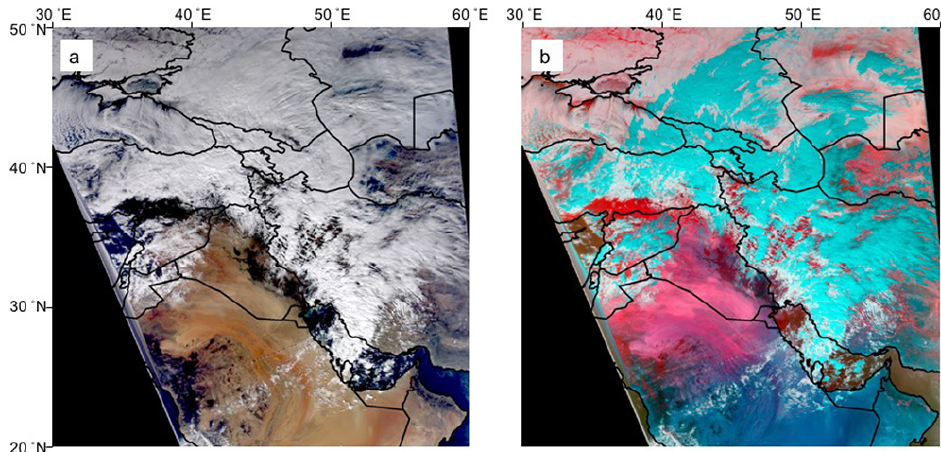
Figure 4. Observations of the lofted dust plume collected at 10:00UTC on 25 January 2010 by the MODIS sensor including the (a) true-color composite and (b) dust-enhanced image produced using the Miller (2003) algorithm, where lofted dust appears pink, landscapes have blue and green hues, and water and steep terrain are